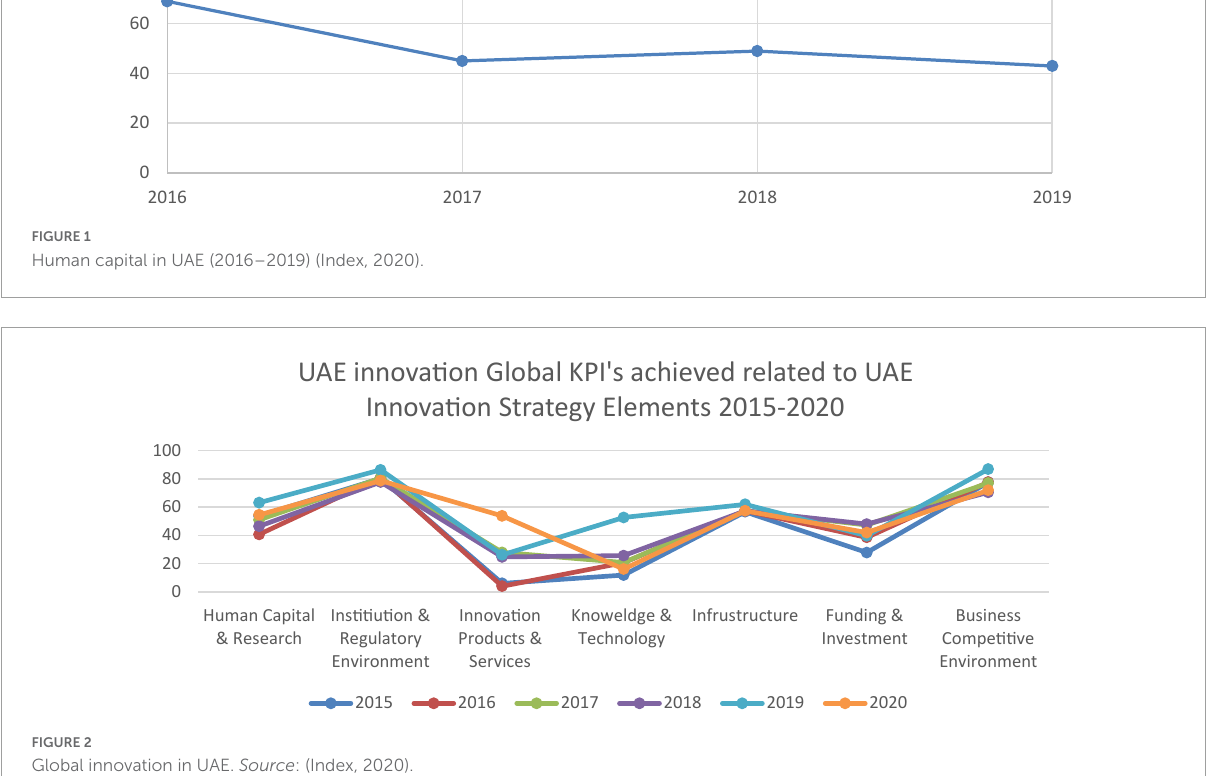
FIGURE2 Global innovation in UAE. Source : (Index,